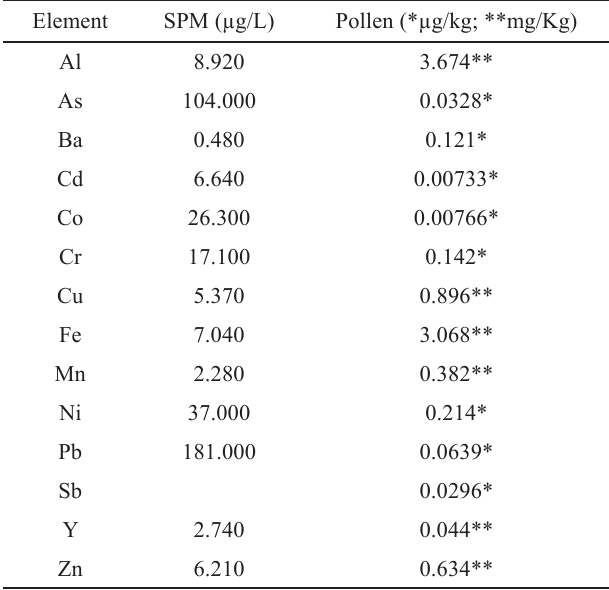
Table 1 . Limits of Quantification (LOQ) for major, minor and trace elements determined by ICP-OES and